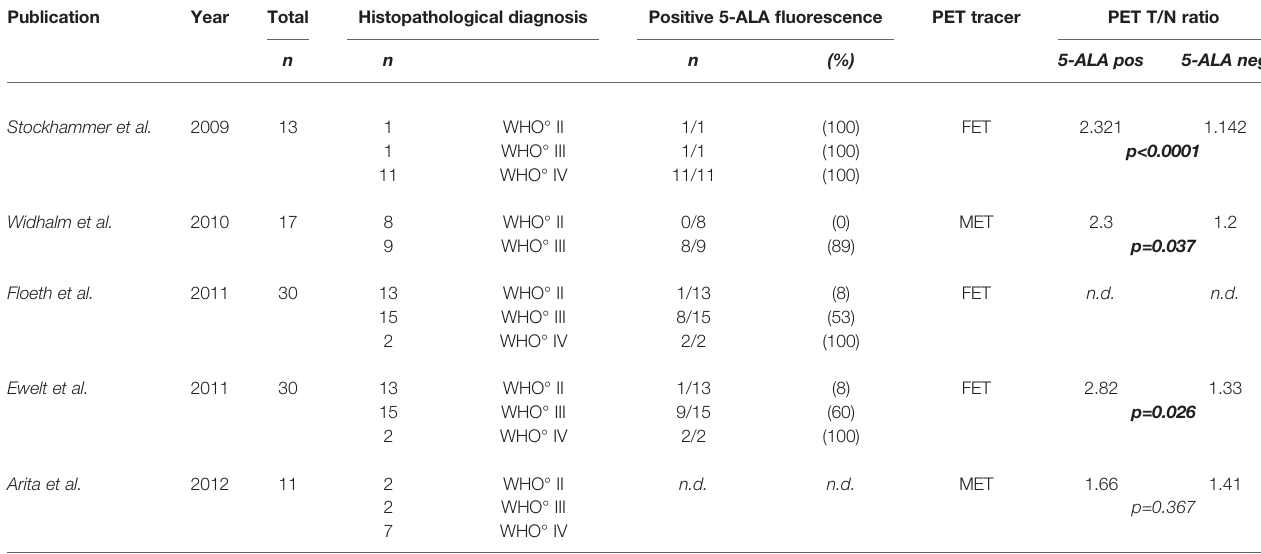
TABLE 2 | Studies in the literature with comparison of PET and visible 5-ALA fl uorescence including LGG (WHO grade